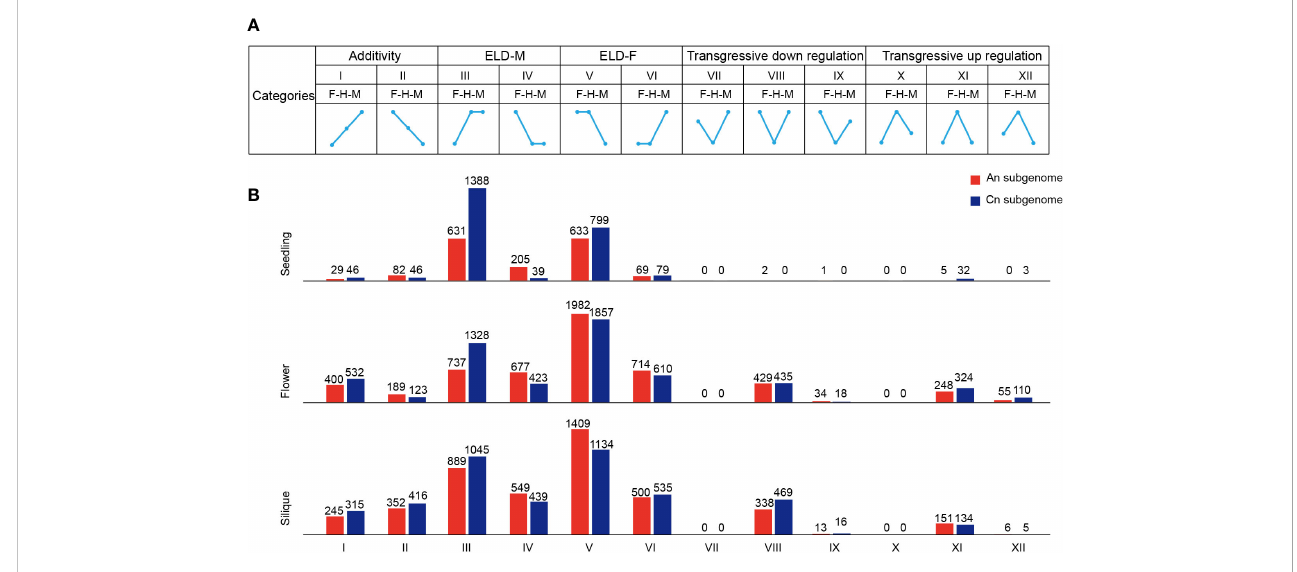
FIGURE 2 Classi fi cation of expressed genes in F1 hybrid. (A) Gene expression patterns of 12 groups in hybrid. F, female parent; H, hybrid; M, male parent. ELD, expression level dominance. (B) Number of genes in 12 groups in the seedling, fl ower bud, and